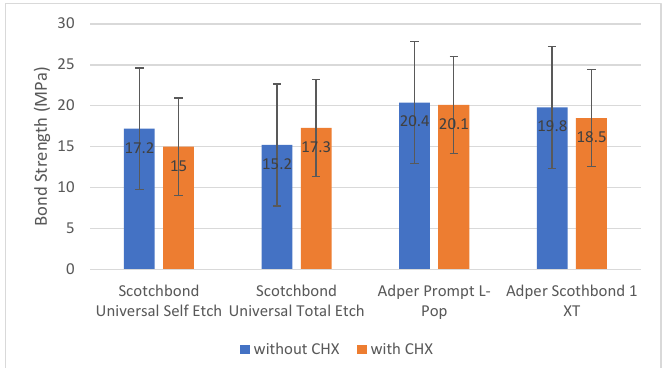
Figure 2. Comparative vision of BS (measured in MPa) by adhesive type and pretreatment. The error bars indicate the total mean standard deviation (SD) of the groups without CHX, and the groups with CHX, respectively.